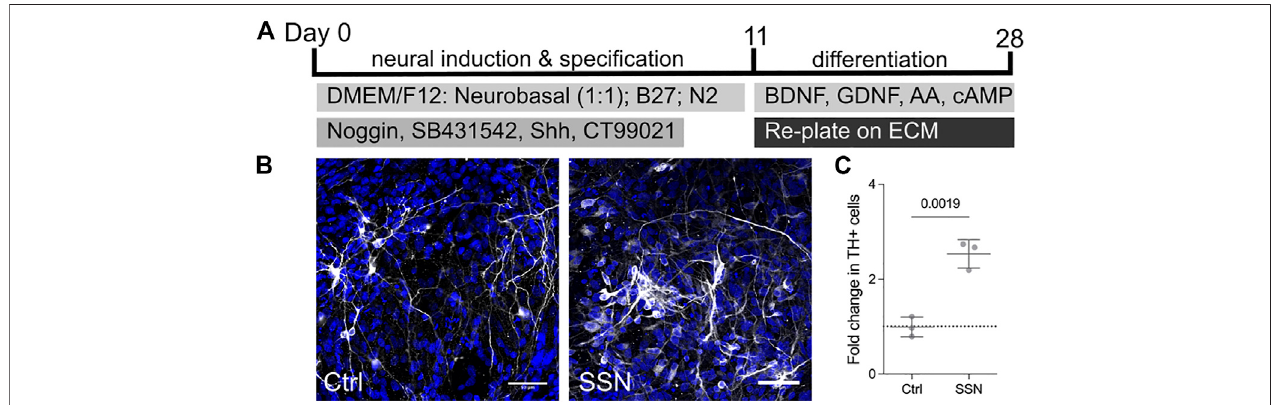
FIGURE 3 | Matricellular proteins increase the number of TH + neurons derived from human embryonic stem cells. Differentiation protocol used for the dopaminergic differentiation of human embryonic stem cells. (B) Immuno fl uorescence images of neurons derived from ES cells with TH positive (white) neurons increased in the presence of matricellular proteins. (C) quanti fi cation of images showing a 2-fold increase in the number of TH positive neurons detected following exposure to matricellular proteins (unpaired t -test, N (cid:1) 3, p (cid:1) 0.0019).